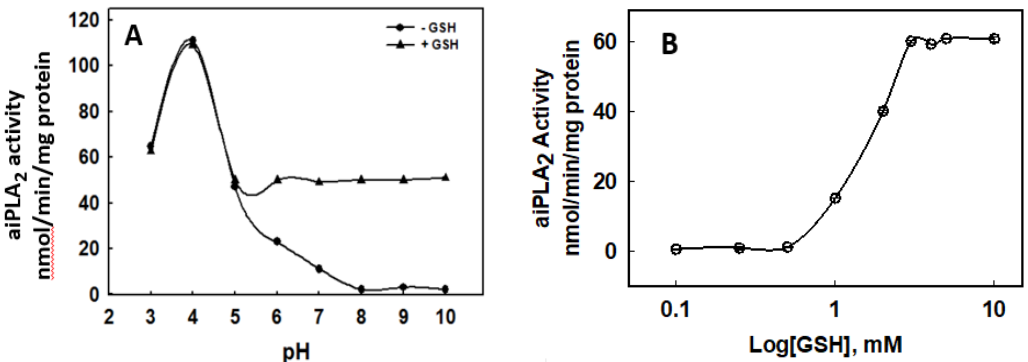
Figure 1. Glutathione (GSH) stimulates the PLA2 activity of Prdx6. ( A ). pH-dependence for the effect of GSH. GSH concentration was 5 mM. ( B ). Effect of GSH concentration on the stimulation of PLA 2 activity. The effect of GSH is maximal at 3